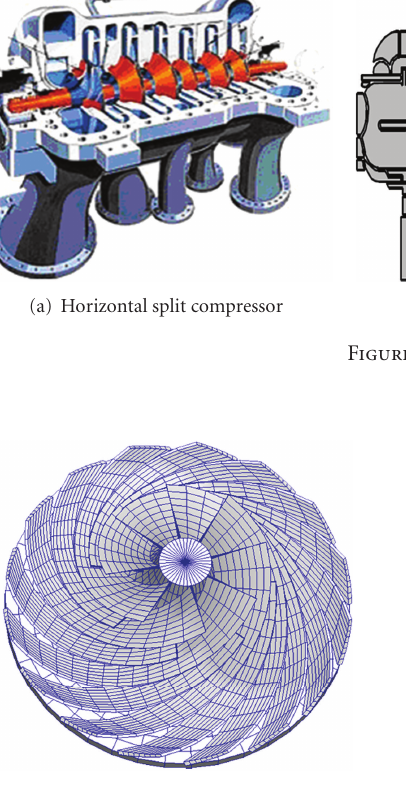
Figure 2: Impeller for